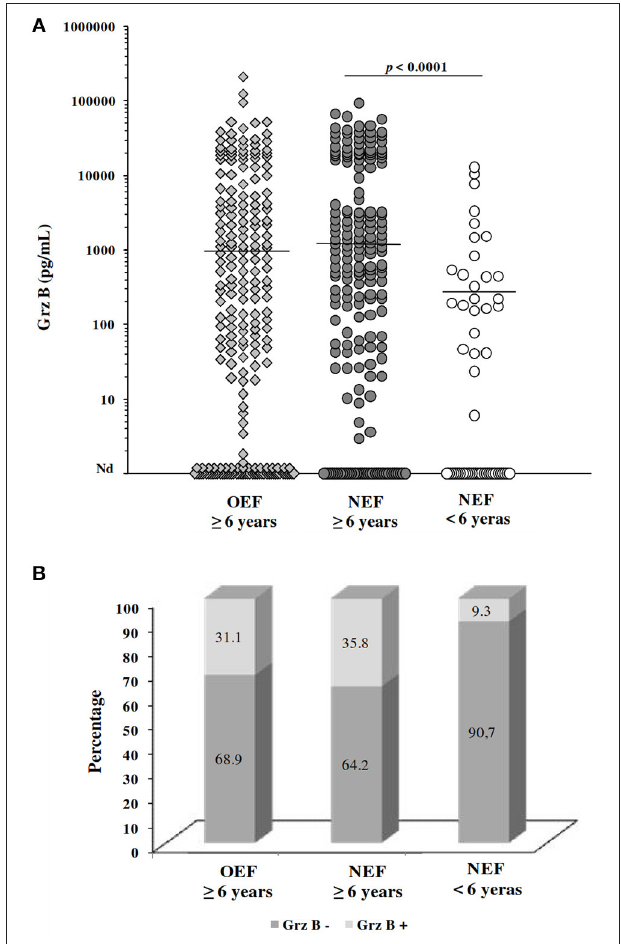
FIGURE 3 | Evaluation of granzyme B levels for subjects included in the prospective study. (A) Grz B levels measured in culture supernatants of PBMCs from individuals, categorized basing on their home focus and their age. Horizontal bars represent median values. (B) Percentage of subjects showing high levels of GrzB ( ≥ 2,000 pg/mL; Grz B + ) and those with levels < 2,000 pg/mL (Grz B − ). OEF: old endemic focus; NEF, New endemic